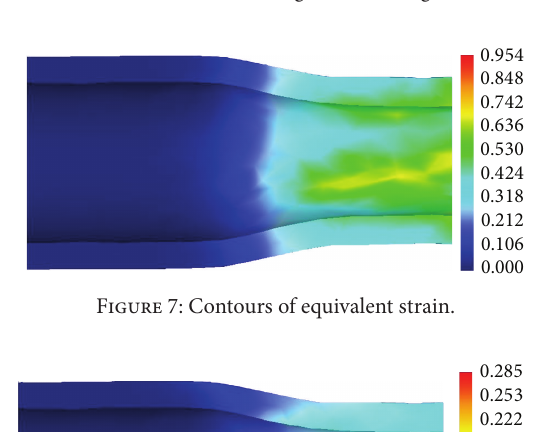
Figure 6: Material damage and forming load.